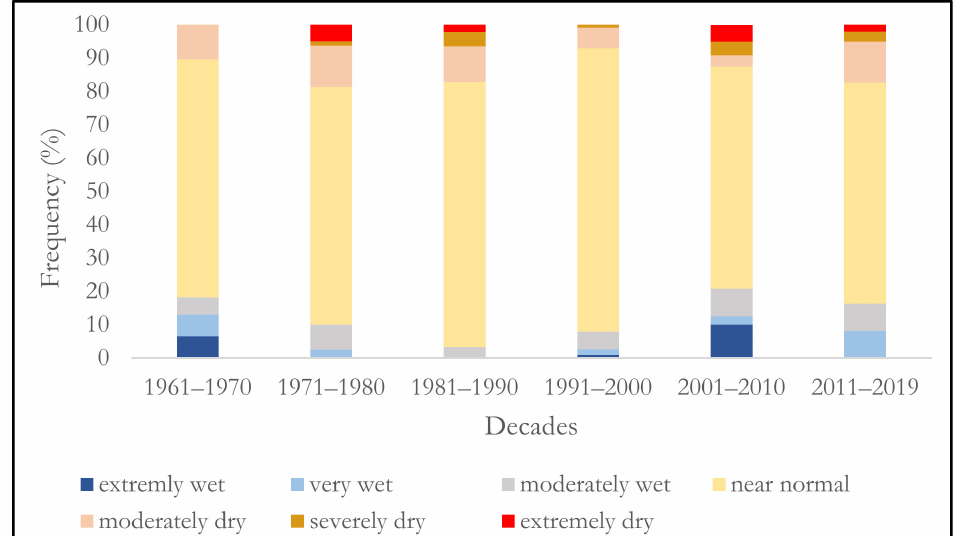
Figure 12. SPI trend by